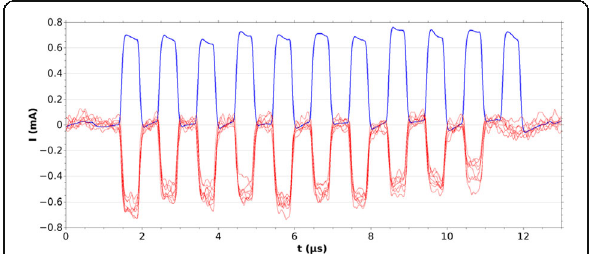
Fig. 24 Experimental results at SNS; intermediate pulses for the H −